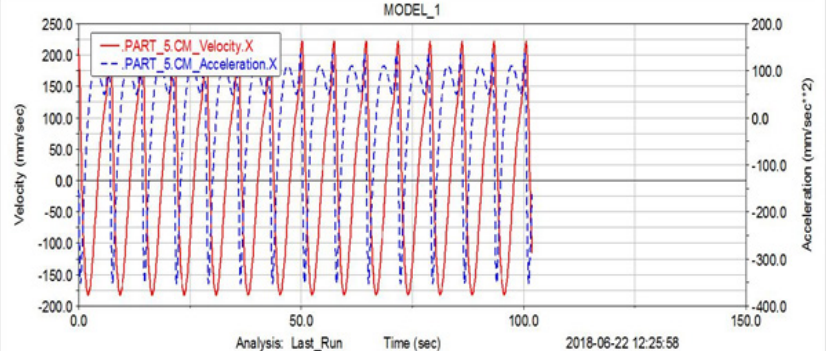
Figure 8: Result of time period versus tool orientation in MSC ADAMS